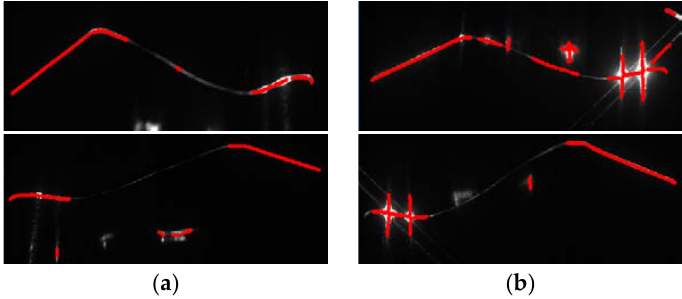
Figure 7. Center extraction results of stripe images. ( a ) Stripe images with low-brightness segments; ( b ) stripe images with overexposed segments.